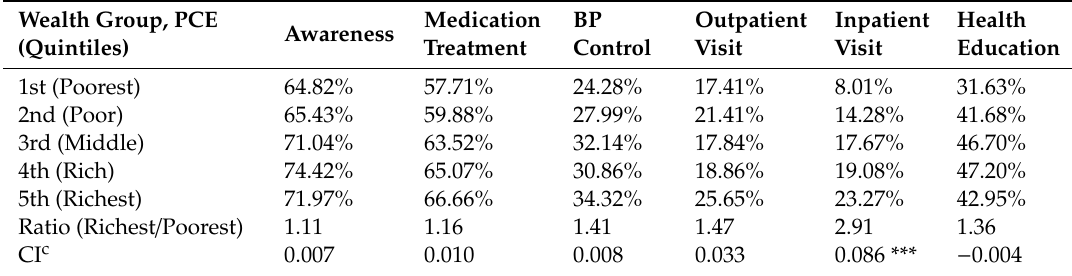
Table 4. Healthcare for hypertensive adults in China across wealth quintiles and concentration indexes, 2015.